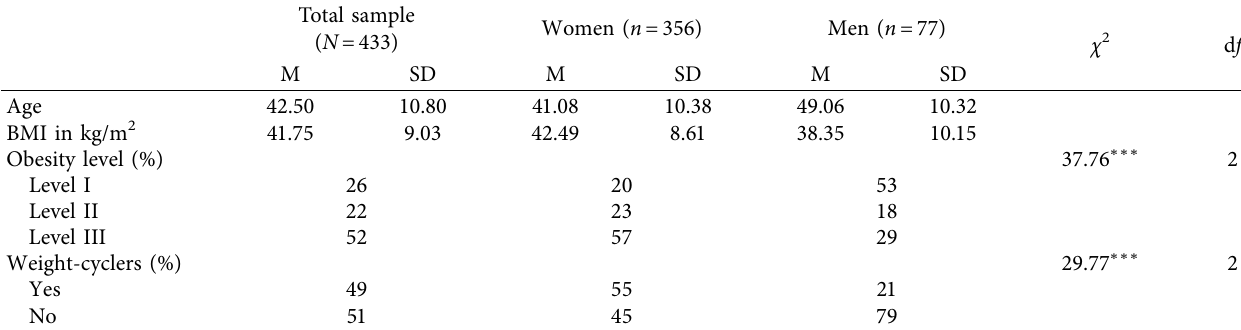
Table 1: Characteristics of the total sample as well as female and male subsamples with gender differences in level of obesity and weight- cycling.